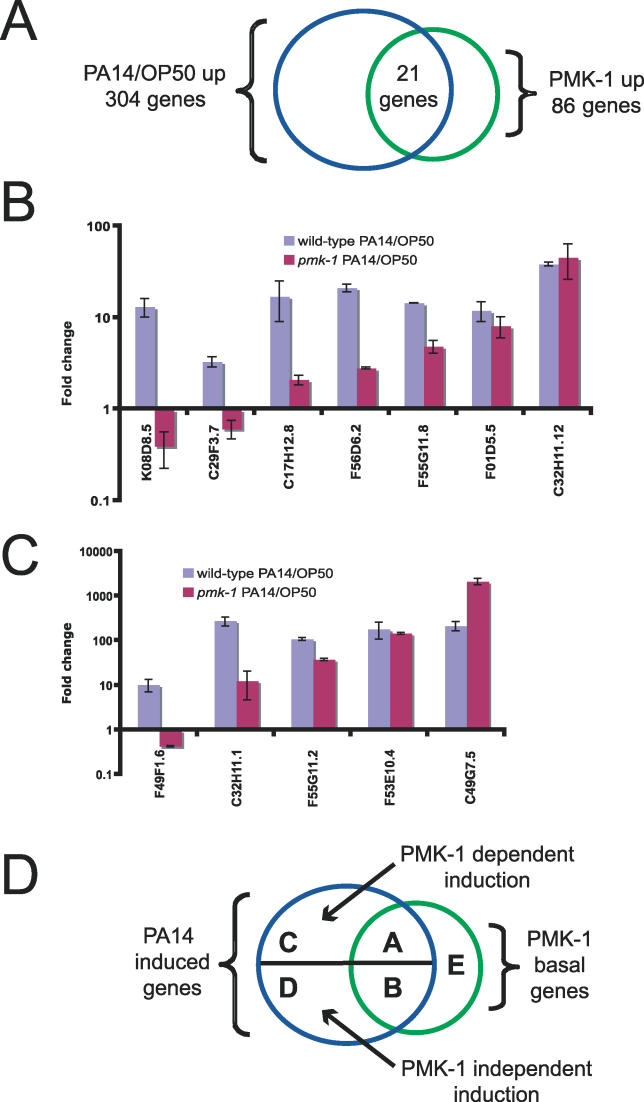
PMK-1 Regulates Basal and Inducible Expression of P. aeruginosa–Induced Genes(A) Venn diagram of overlap between genes regulated by PMK-1 and P. aeruginosa.
(B) (C) qRT-PCR analysis of PA14-induced gene expression in wild-type animals and in pmk-1 mutants. Results are the average of two biological replicates, each replicate measured in duplicate and normalized to a control gene. Error bars are SEM.(D) Diagram of different gene classes regulated by PMK-1 and/or P. aeruginosa. PMK-1 is required for basal and inducible regulations of class A genes. PMK-1 is required for basal, but not inducible expression of class B genes. PMK-1 is required for inducible but not basal expression of class C genes. PMK-1 is required for neither basal nor inducible expression of class D genes. PMK-1 regulates basal expression of class E genes, but these genes are not induced by P. aeruginosa.